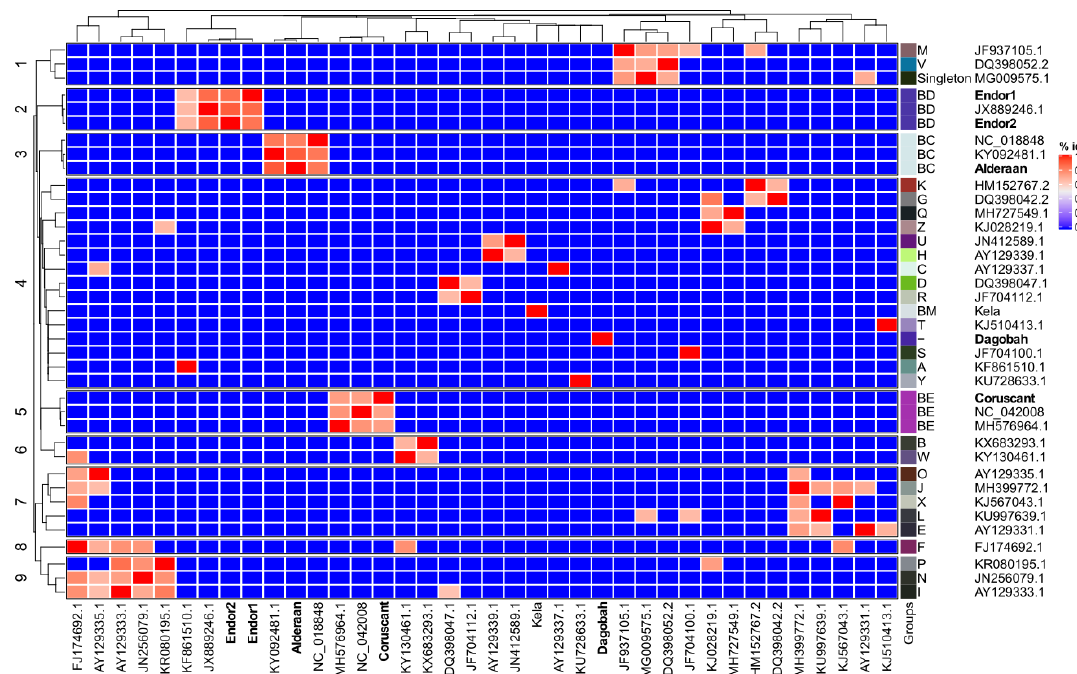
Figure 4. Average nucleotide-based dendrogram analysis using 38 actinophage genomes. These 38 genomes include 31 genomes downloaded from the Actinophage Database (https://phagesdb.org/), two genomes from NCBI based on close relatedness, and the five newly sequenced phages. The group of each phage, as defined by the Actinophage Database, is indicated.